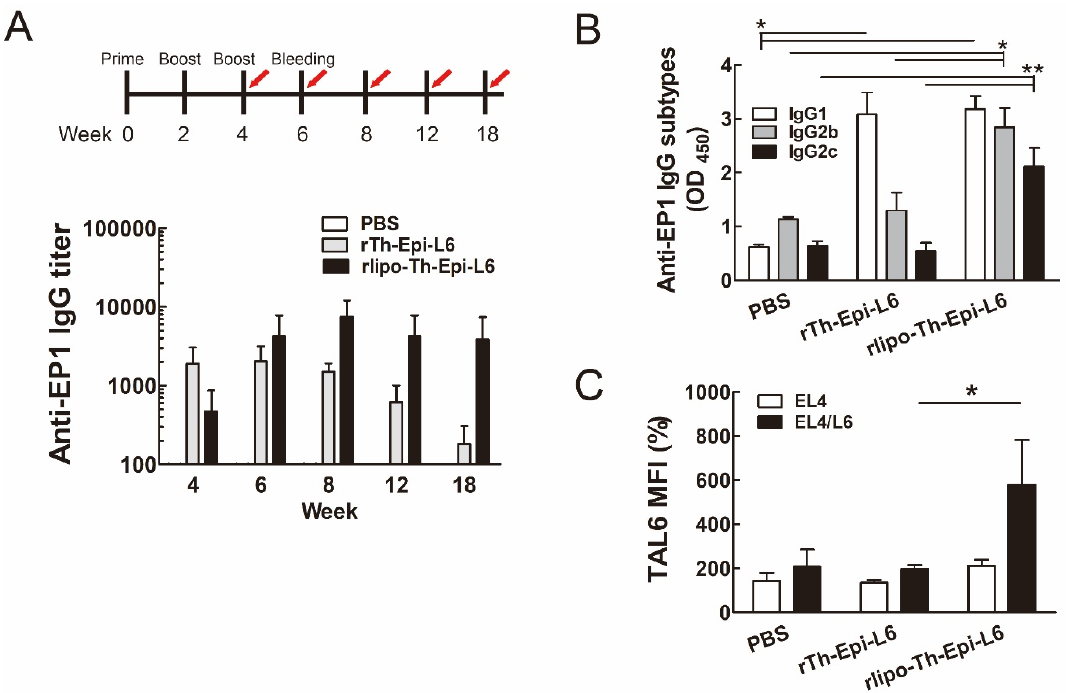
Figure 4. Immunization with rlipo-Th-Epi-L6 induced higher levels of anti-Ep1 antibody and Th1 immunity. ( A ) The immunization schedule in C57BL/6 mice ( n = 6, per group) involving 3 injections (1 prime and 2 boosts) at 2-week intervals. Serum samples were collected from immunized mice at the indicated time points (red arrows) after the first immunization. Anti-EP1 IgG titers were determined using ELISA. ( B ) The subtypes of anti-EP1 IgG were determined. ( C ) The ability of immunized mouse serum to recognize TAL6 on cancer cell surface, depicted as the mean fluorescence intensity (MFI). The data are presented as the mean ± SEM of triplicate samples. * p < 0.05, ** p < 0.01 by t ‐ test.